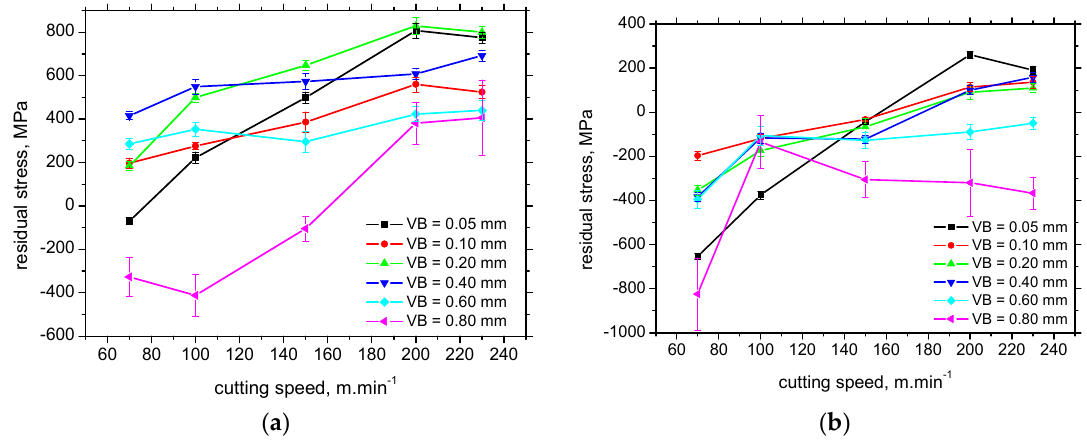
Figure 4. Evolution of surface residual stresses with cutting speed. ( a ) CD, ( b ) FD. The non-systematic evolution of residual stresses of VB, as well as the different gra- dient of the ascend with the cutting speed (or the descending evolution), should be linked with the altered contribution of the “sandwich” microstructure after hard turning. The